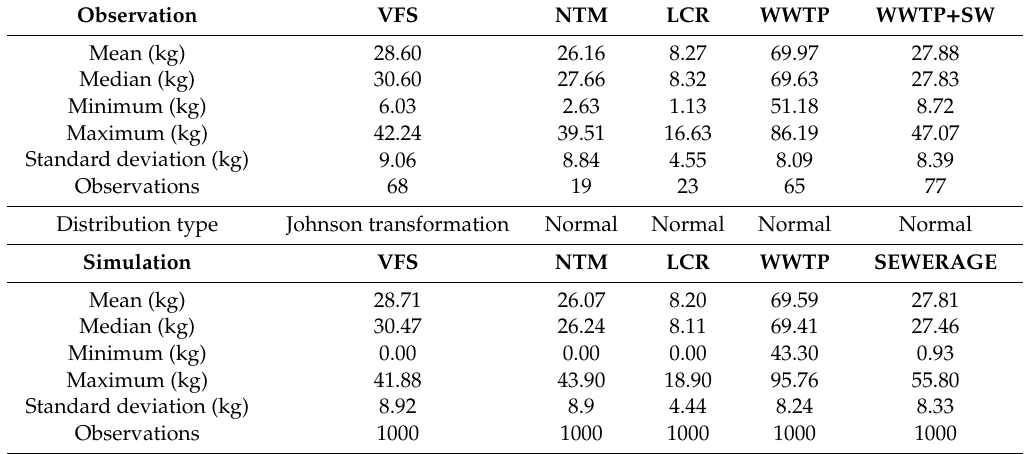
Table 2. Descriptive statistics of collected and simulated data for measures entering the